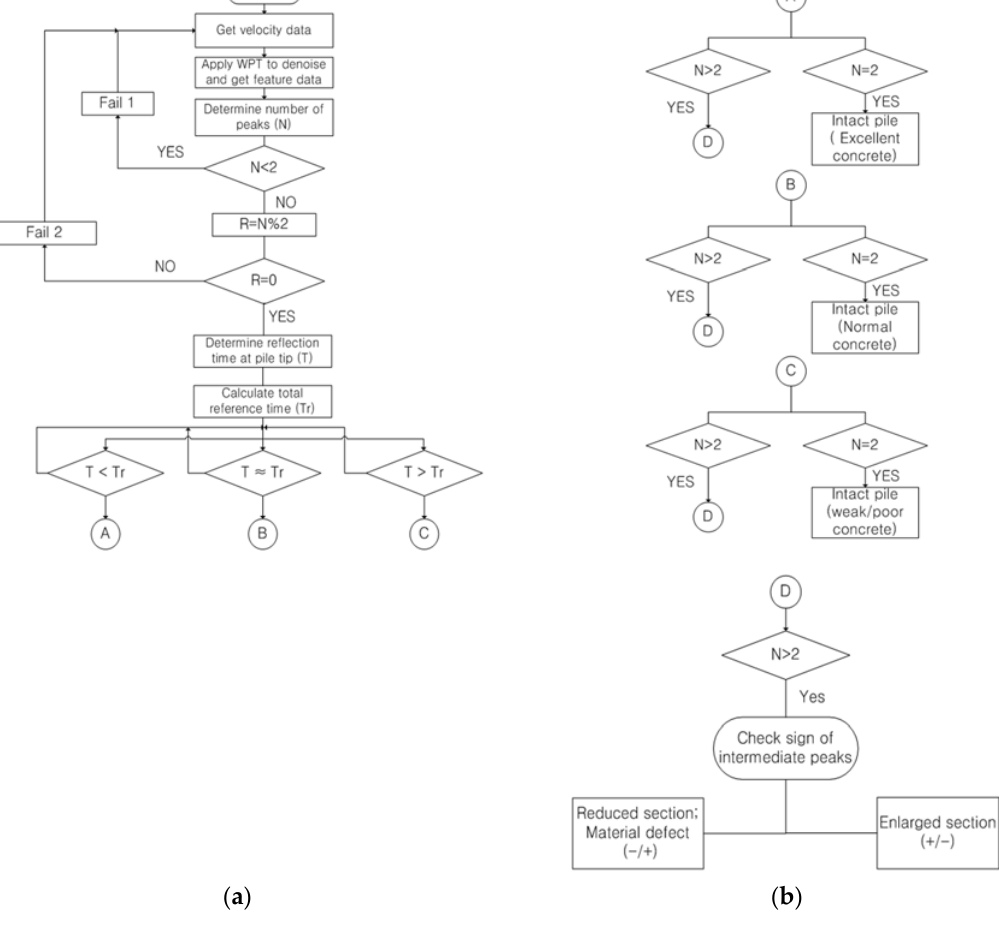
Figure 7. Pile defect identification scheme: ( a ) Flowchart for pile defect diagnosis; ( b ) Detailed flowchart for diagnosis based on reference reflection time and the number of peaks.